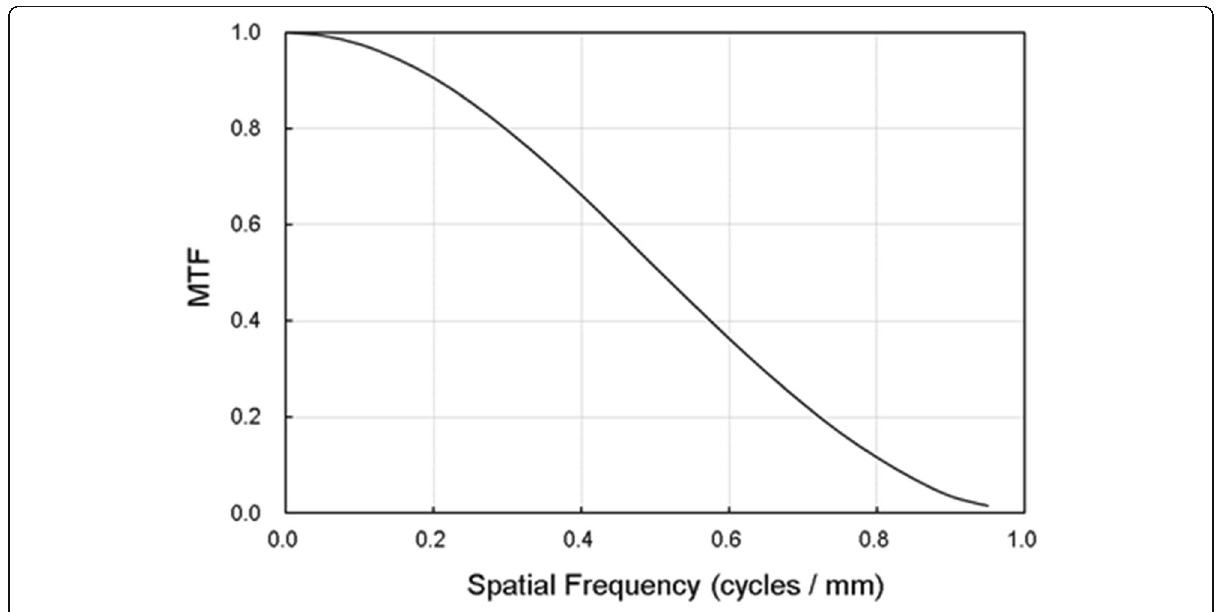
Fig. 2 CT unit-specific modulation transfer